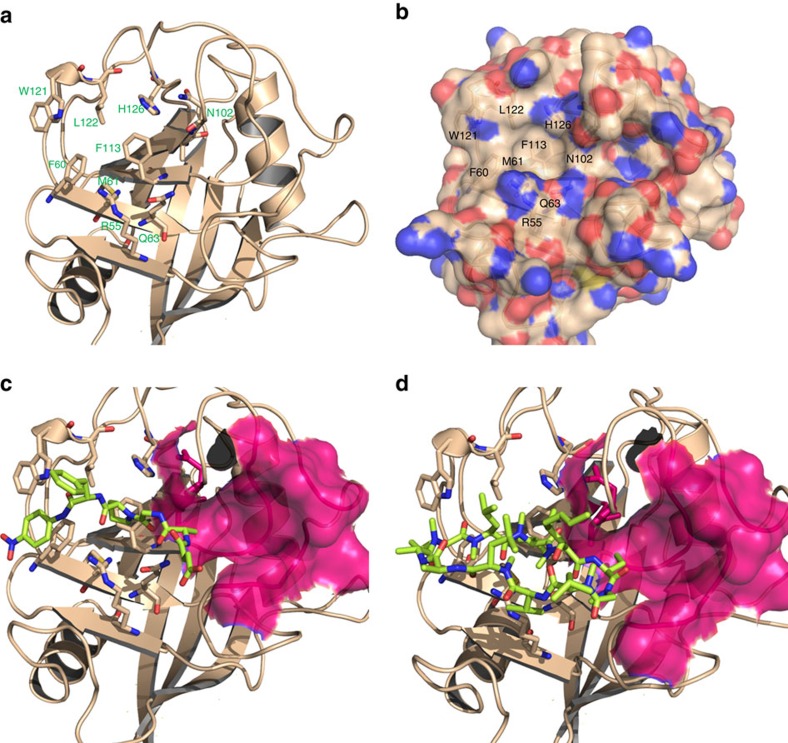
Crystal structure of CypA alone or in complex.(a) Cartoon representation of CypA, with the catalytic residues in stick format. (b) Surface representation of CypA showing the catalytic pocket (left) and the gatekeeper pocket (right). (c) Cartoon representation of PDB 1ZKF showing the catalytic residues and the succinyl-AGPF-pNA substrate (green) in stick format, and the gatekeeper pocket in surface representation (pink). (d) Cartoon representation of PDB 1CWA showing the catalytic residues and the cyclophilin inhibitor CsA (green) in stick format, and the gatekeeper pocket in surface representation (pink).